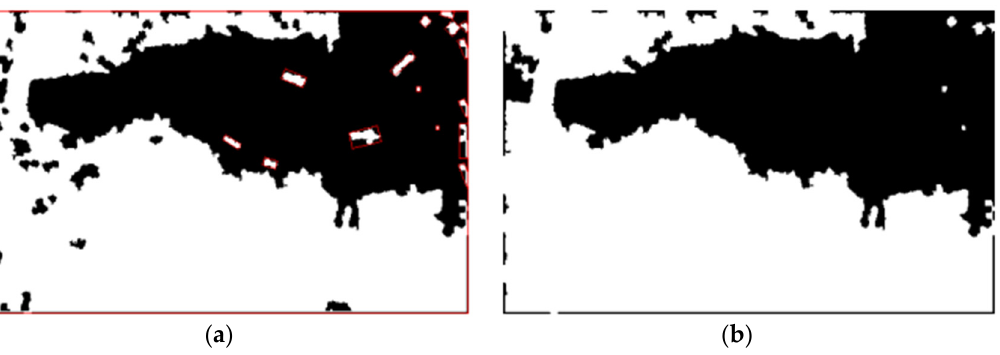
Figure 9. Geometric feature processing diagram: ( a ) schematic diagram of the smallest enclosing bounding area of the object; ( b ) image mask.